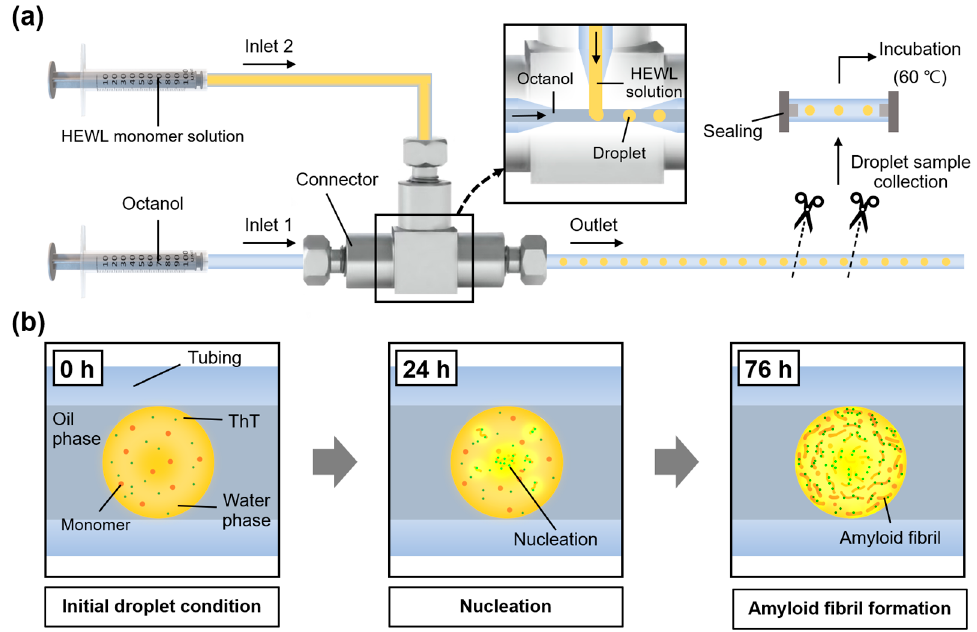
Figure 1. Schematic illustration of nanoliter-droplet-generation model for investigating amyloid formation. ( a ) Design of microfluidic system for droplet generation. ( b ) Illustration of time-resolved observation inside nanoliter droplet from nucleation to fibrillation of HEWL over time (0–76 h).